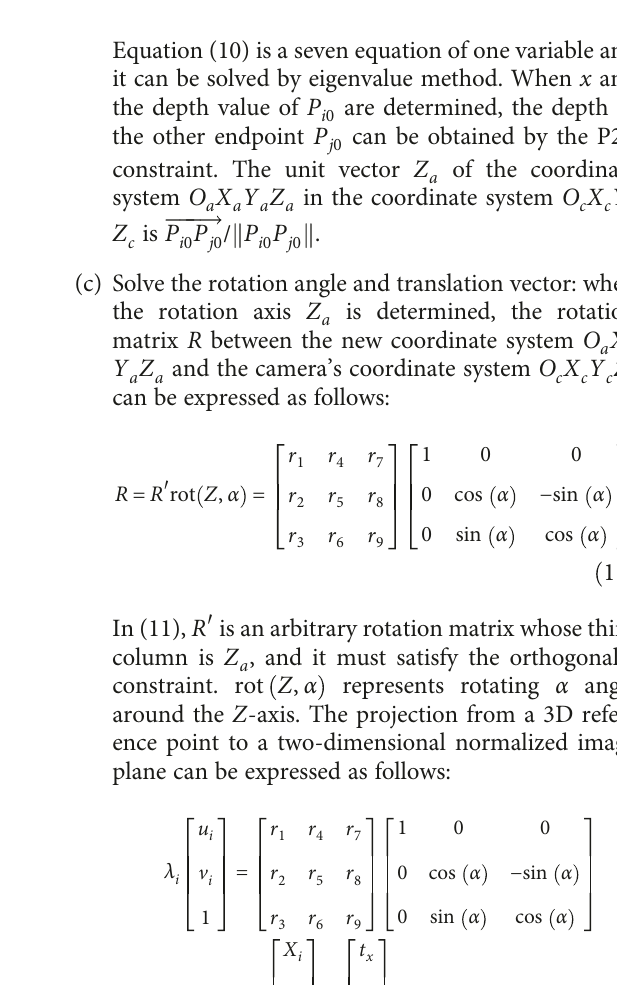
Figure 15: The projection of reference